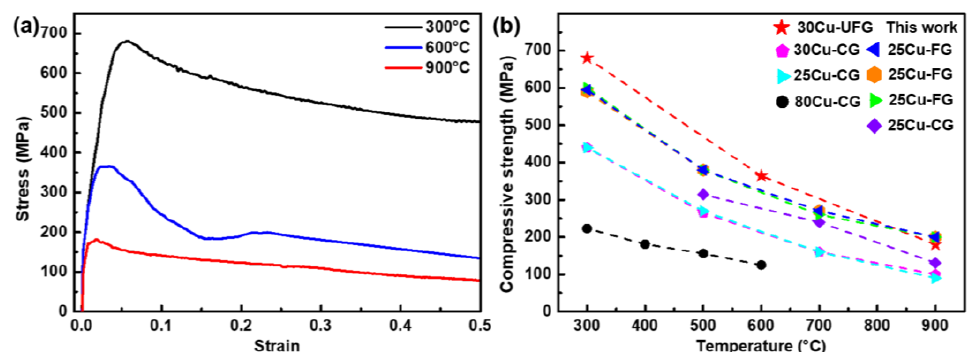
Figure 8. ( a ) Compressive strain–stress curves at different temperatures of the UFG W–Cu composite. ( b ) Comparison of the high-temperature compressive strength between UFG W–Cu and counterparts reported in the literature [12,24,25,27,35,40], where CG and FG denote coarse-grained and fine-grained samples,